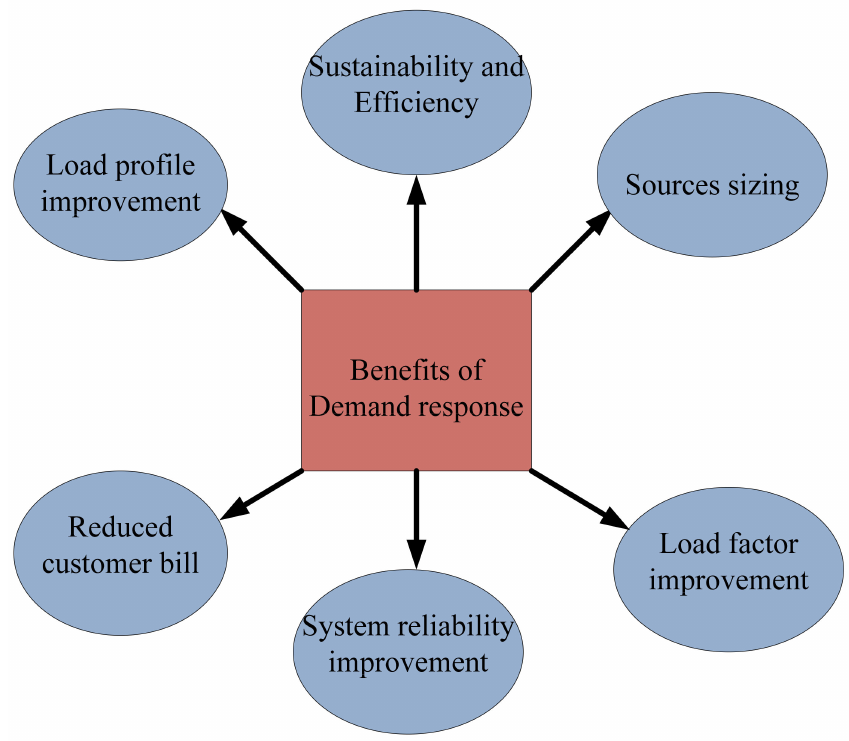
Figure 9. Merits of DR strategies.